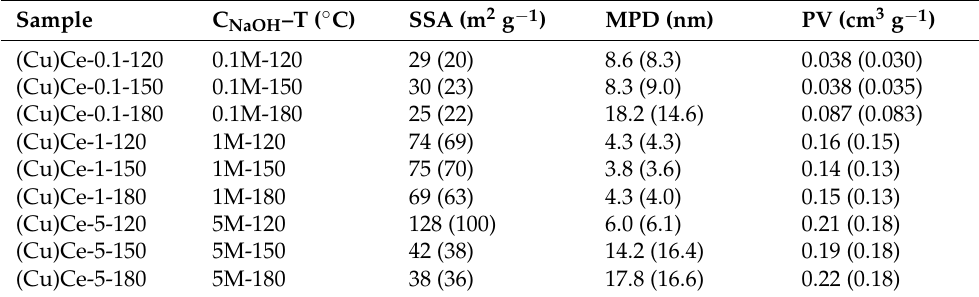
Table 1. Specific surface area (SSA), mean pore diameter (MDP) and pore volume (PV) of ceria and CuCe oxides. The numbers in brackets refer to the CuCe oxide catalysts.